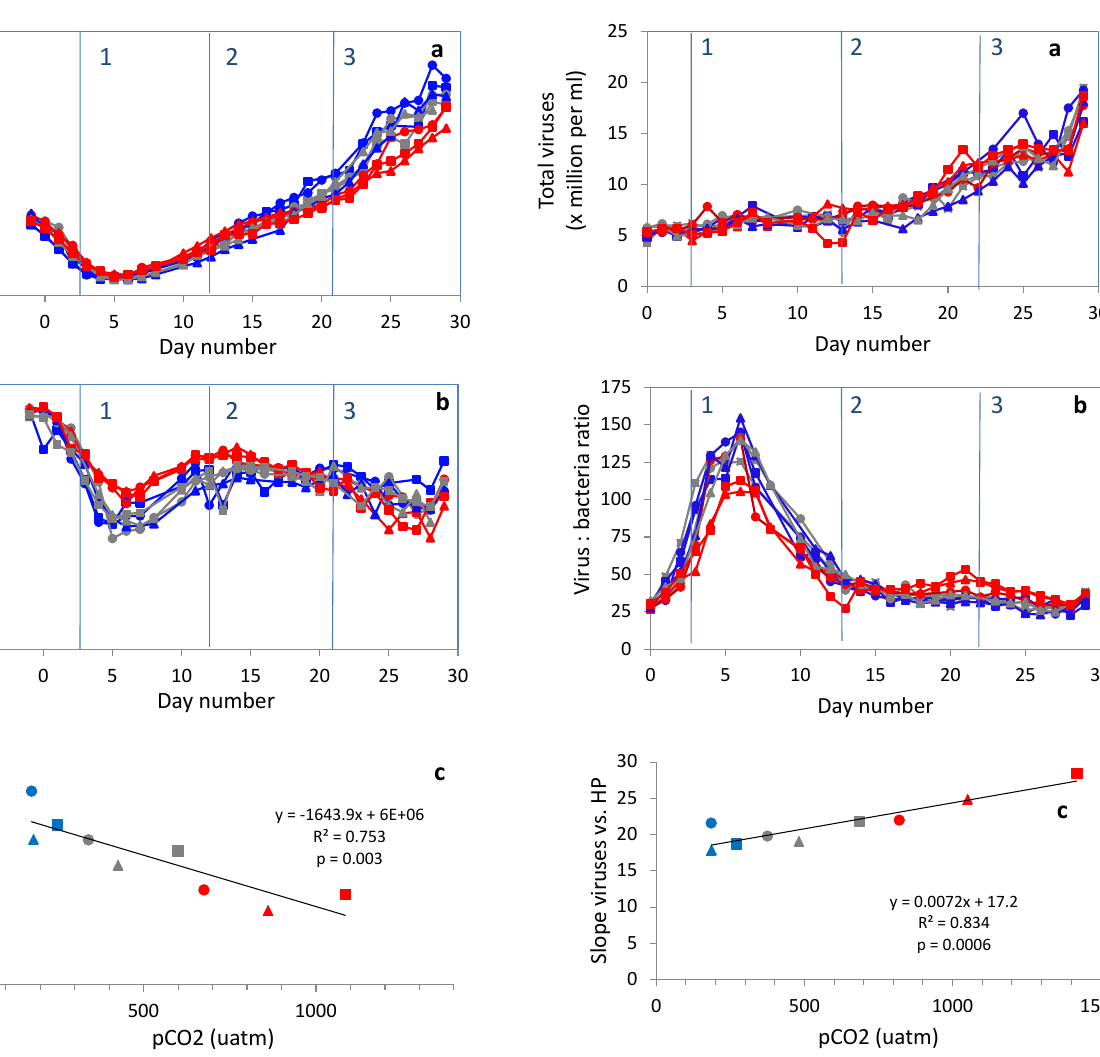
Fig. 7. Temporal development of heterotrophic prokaryotes HP (a) and HDNA HP (b) . The abundance of HP at t 28 versus p CO 2 (av- erage of t 8 to t 27) is plotted in (c) . For color and symbol coding, see Fig. 1. For (c) , the linear regression statistics are provided in plot.